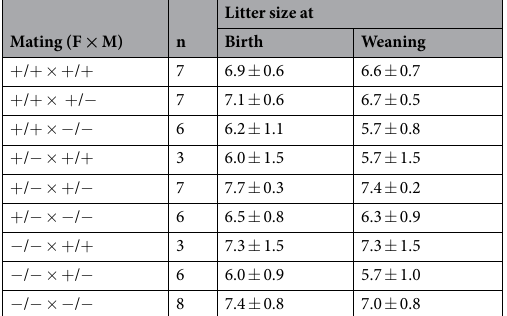
Table 1. Breeding results from 9 different types of